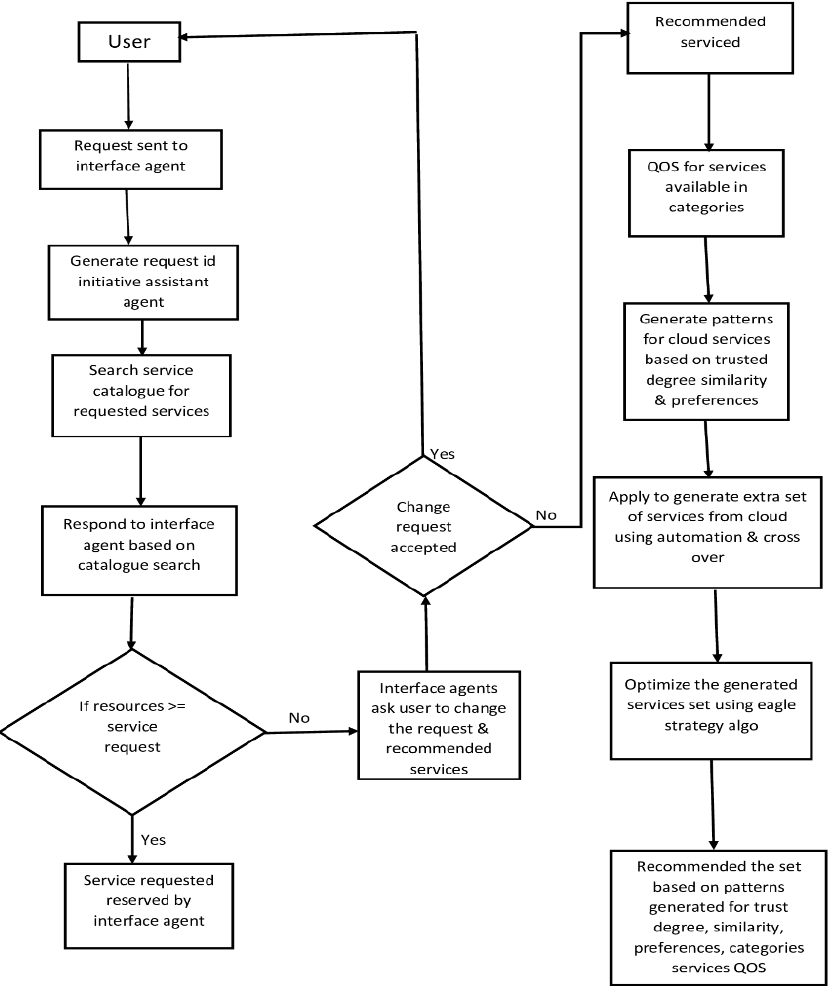
Figure 2. Proposed Framework.